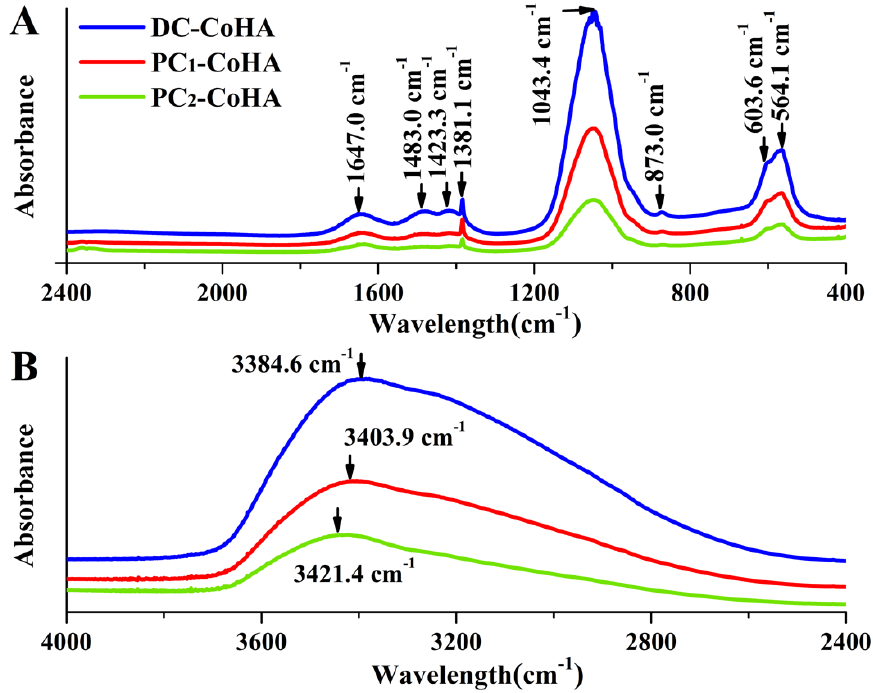
Figure 3. The attenuated total reflectance-Fourier transform infrared spectroscopy (ATR-FTIR) spectrum of the CoHA particles. ( A ) at 400–2400 cm −1 range, ( B ) at 2400–4000 cm −1 range.